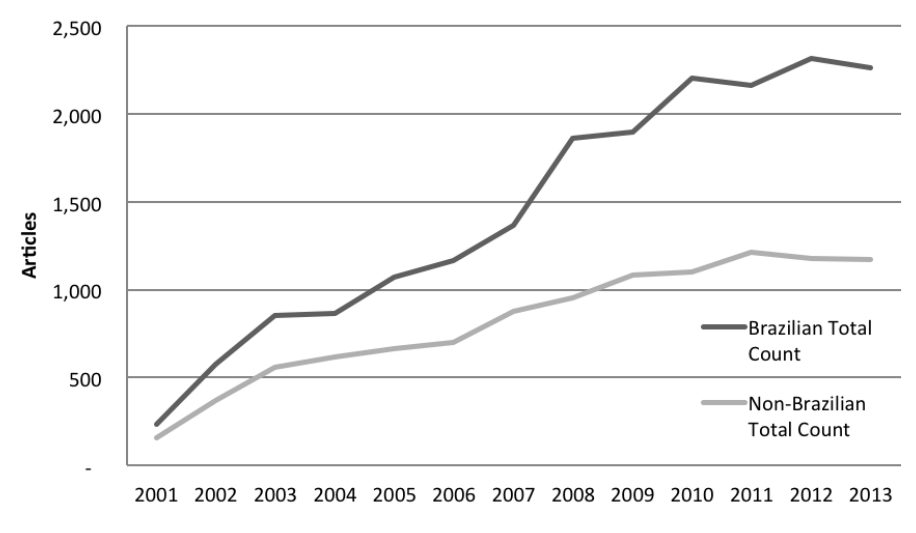
Figure 1. Latin American Articles Published Each Year: 2001-2013.